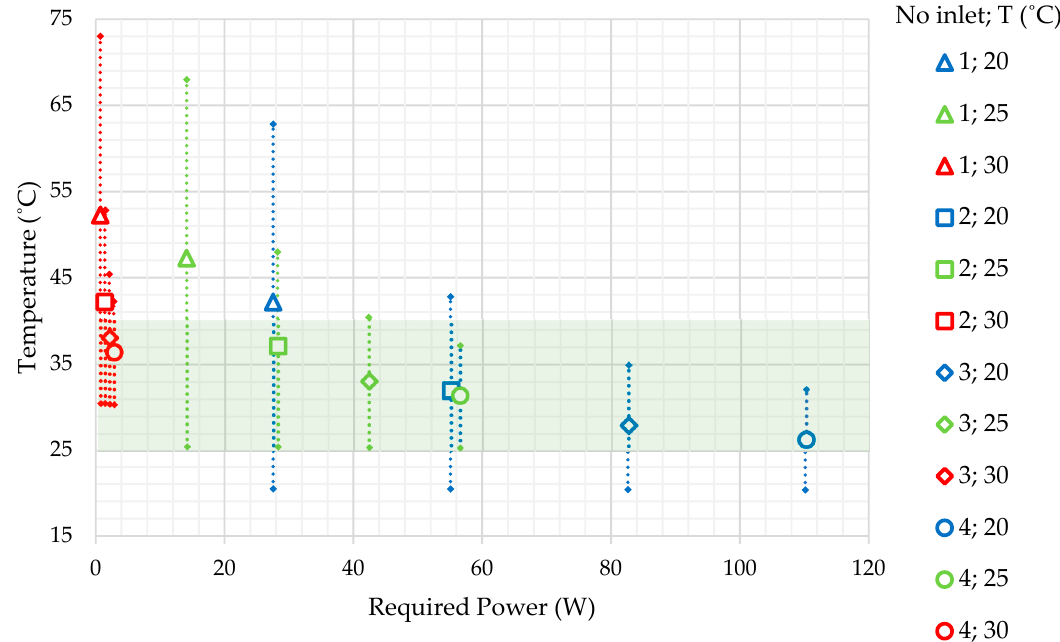
uration. The green shaded area represents the area of optimal operational temperature for the lithium-ion battery.